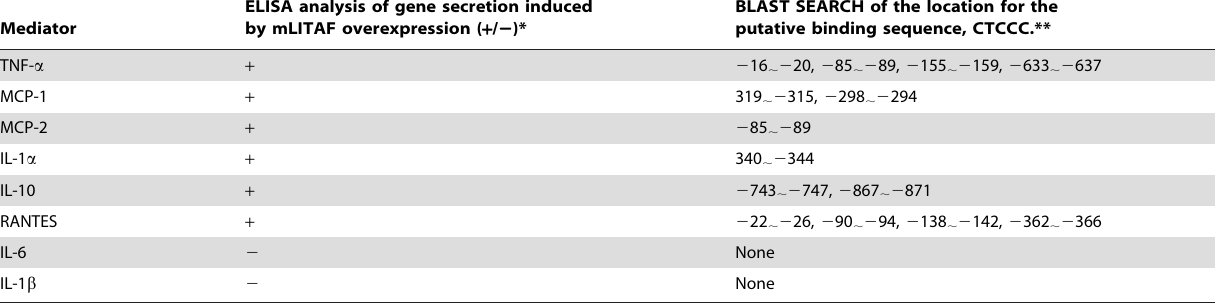
ELISA analysis of gene secretion induced by mLITAF overexpression ( + / 2 )*